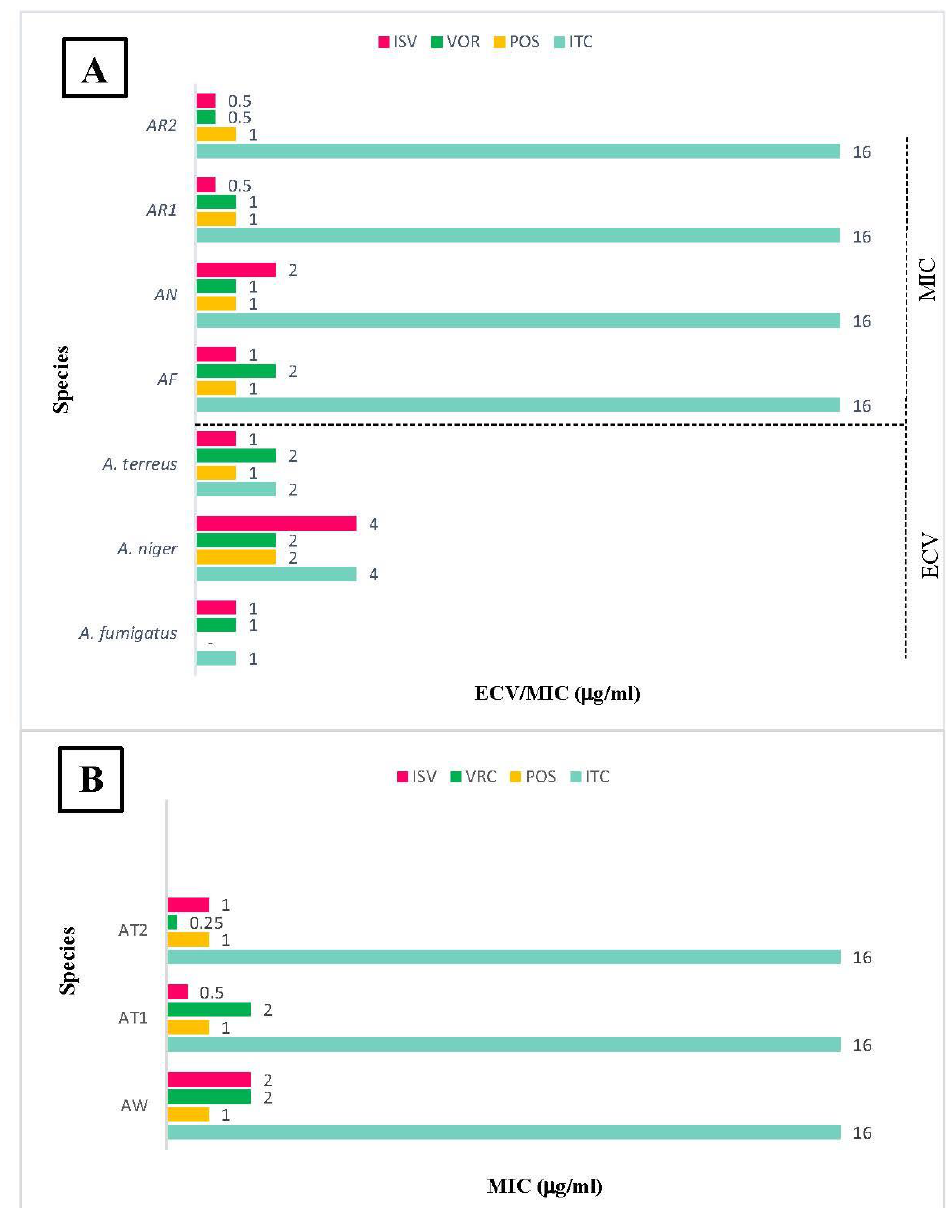
Figure 2. ( A ) The distribution of minimum inhibitory concentrations (MICs) of different Aspergillus isolates against tested triazoles compared to epidemilogical Cutoff values (ECVs). ( B ) The MICs of different Aspergillus isolates without defined ECV against tested triazoles.